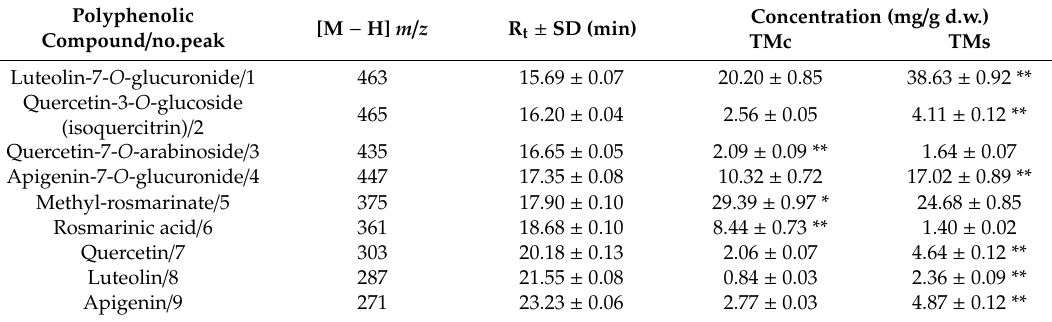
Table 1. HPLC quantification of polyphenolic compounds from T. marschallianus. Polyphenolic Compound / no.peak